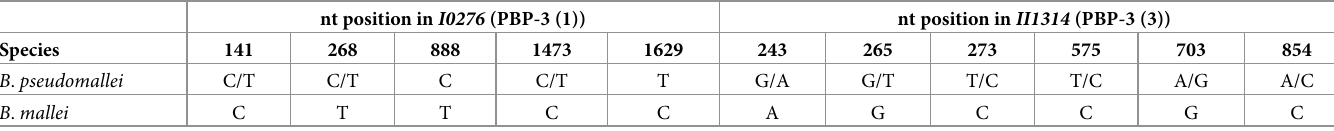
Table 4. Dual-locus sequence typing